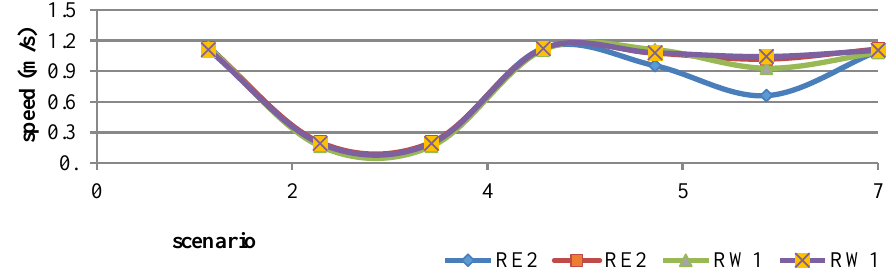
Figure 4. Speed results in accordance with different monitored scenarios.